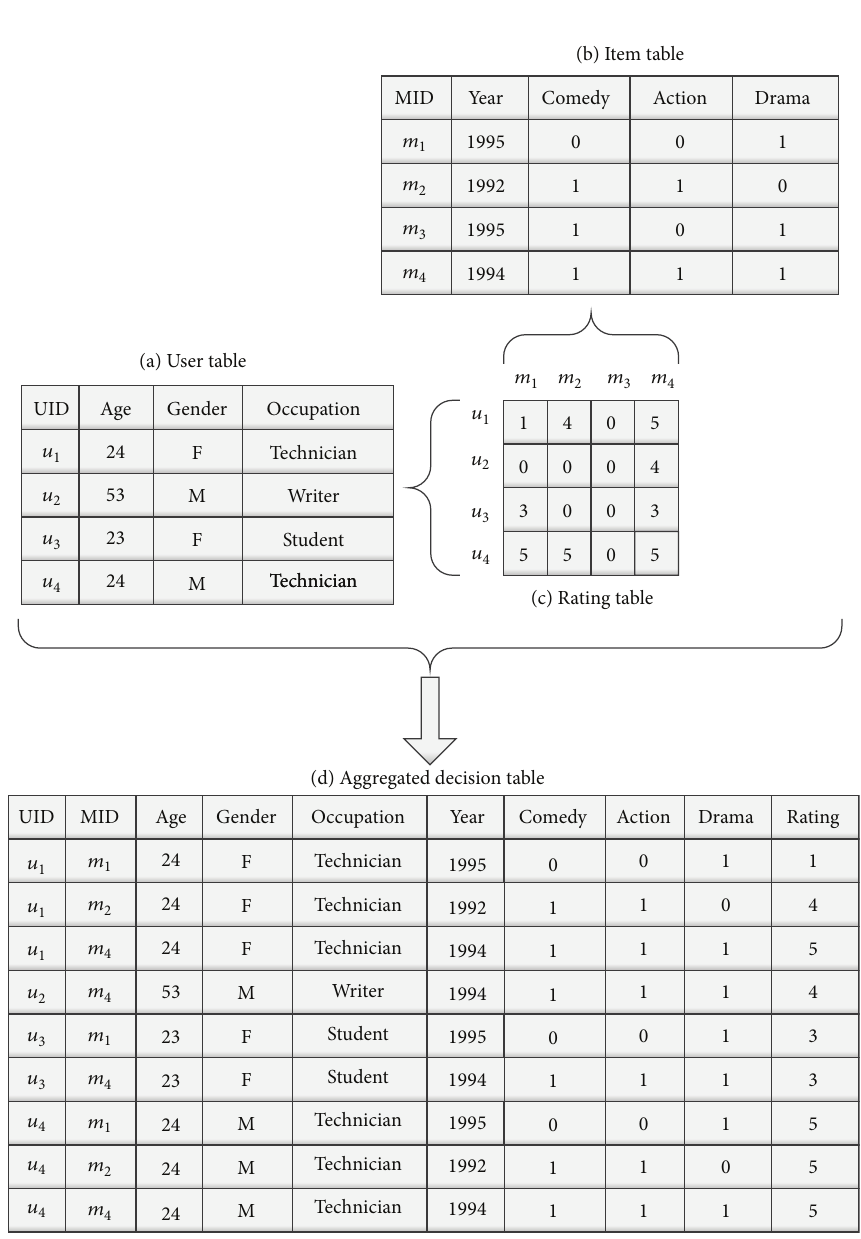
Figure 1: Aggregated decision